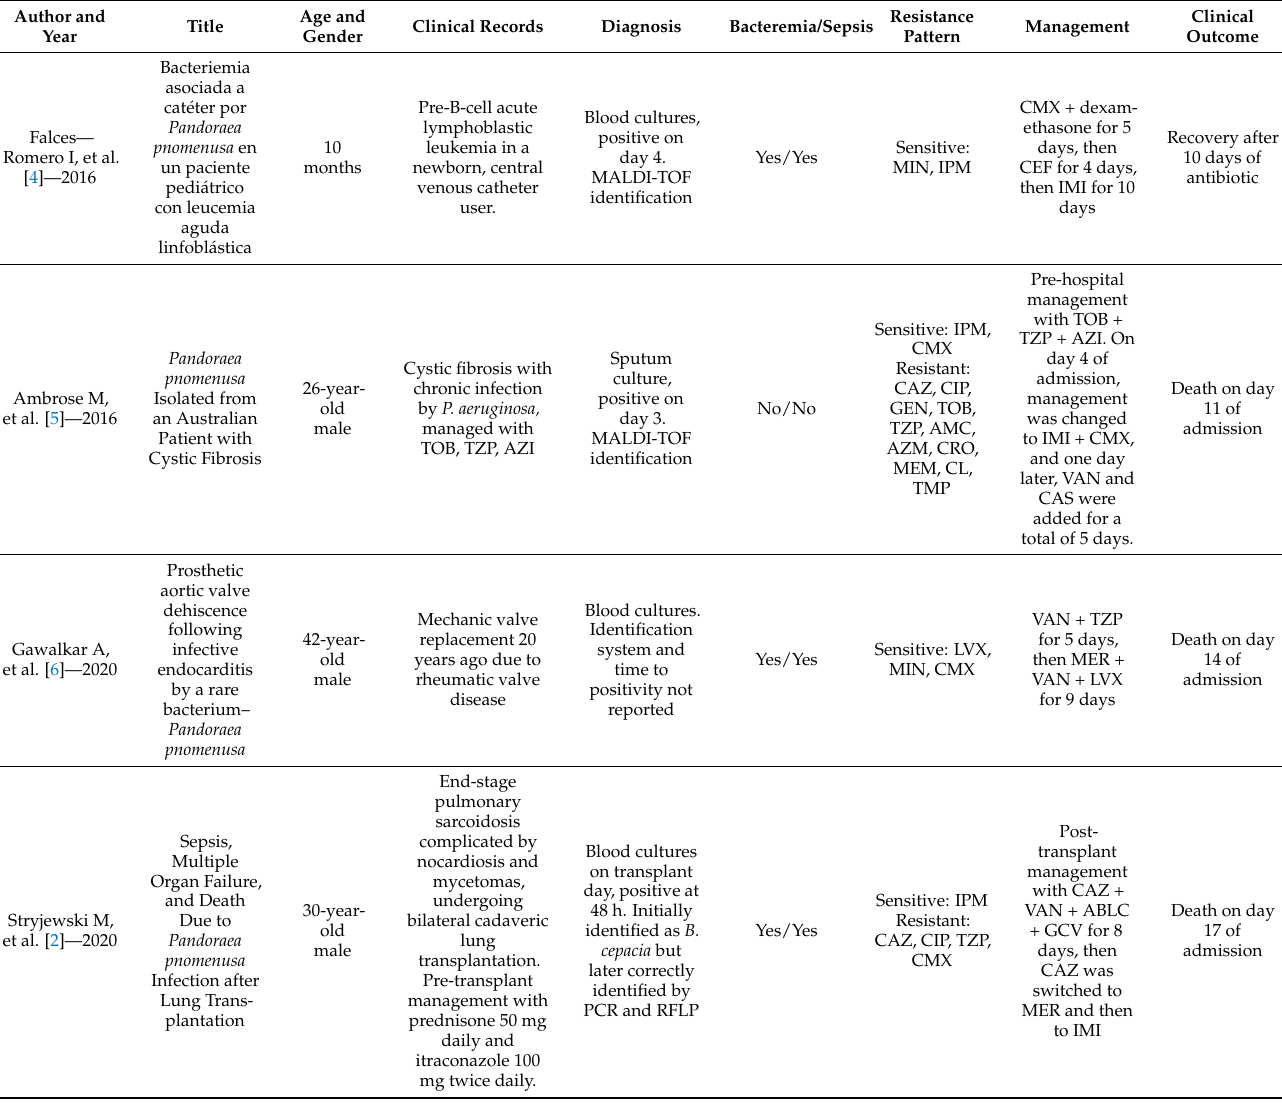
Table 3. Cases of P. pnomenusa infection reported